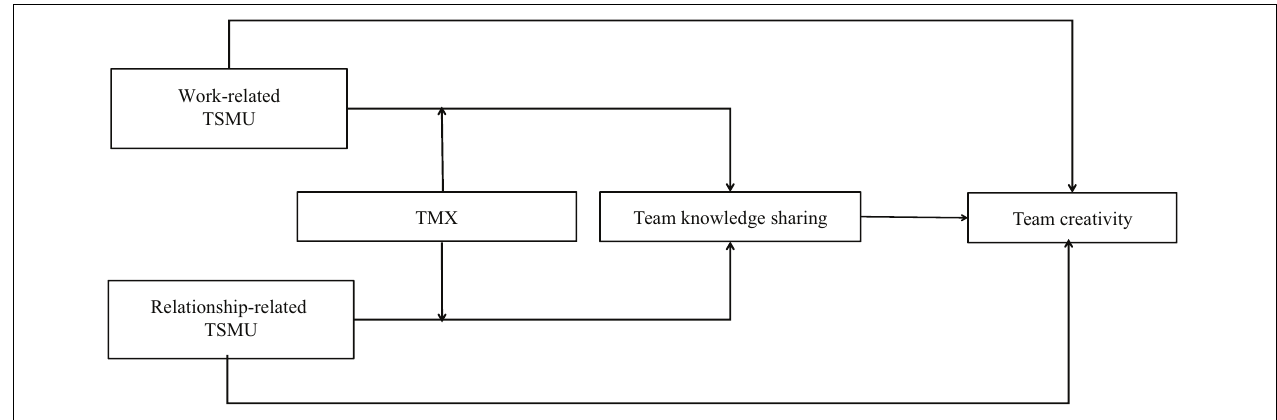
FIGURE 1 | Theoretical